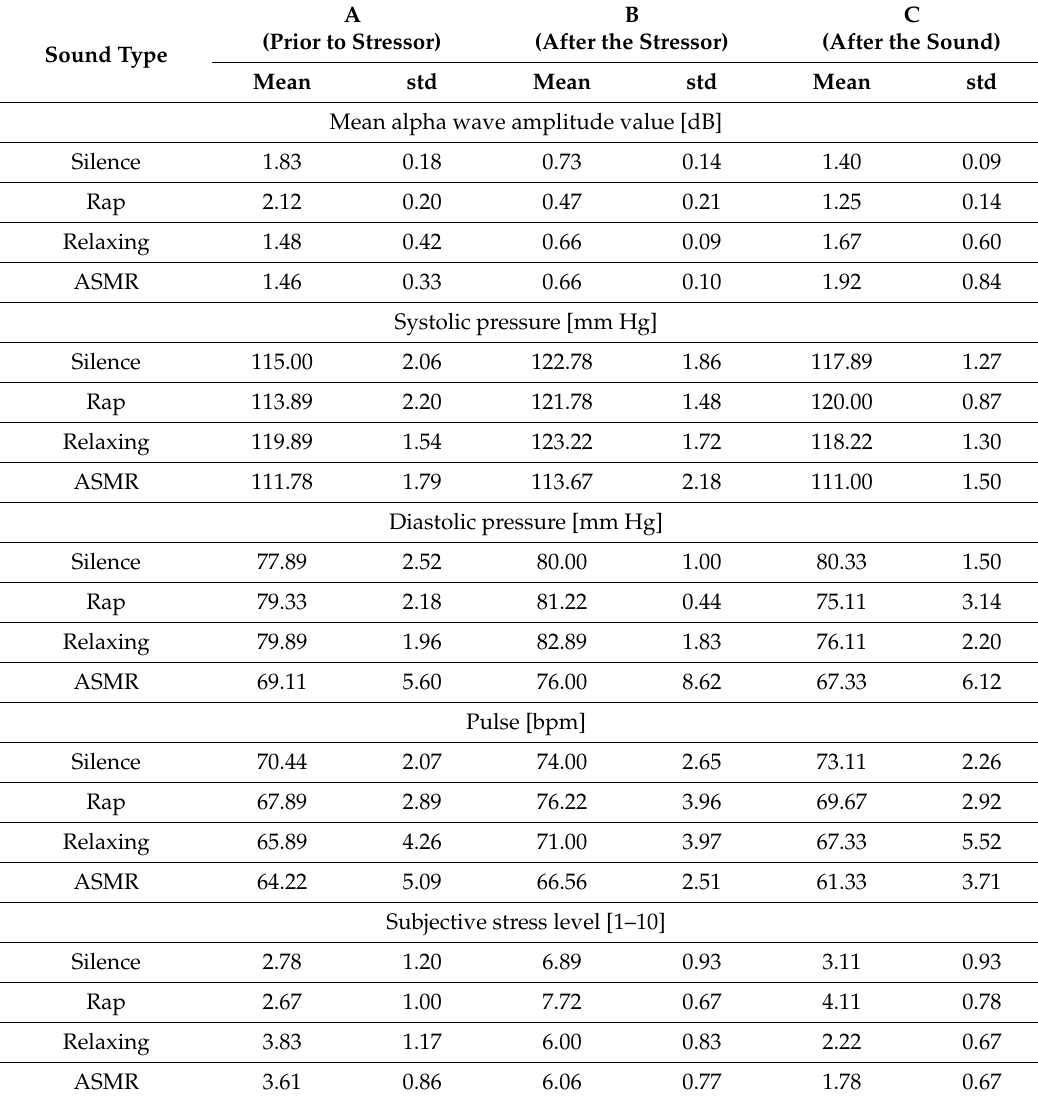
Table 3. The mean and standard deviation of measured